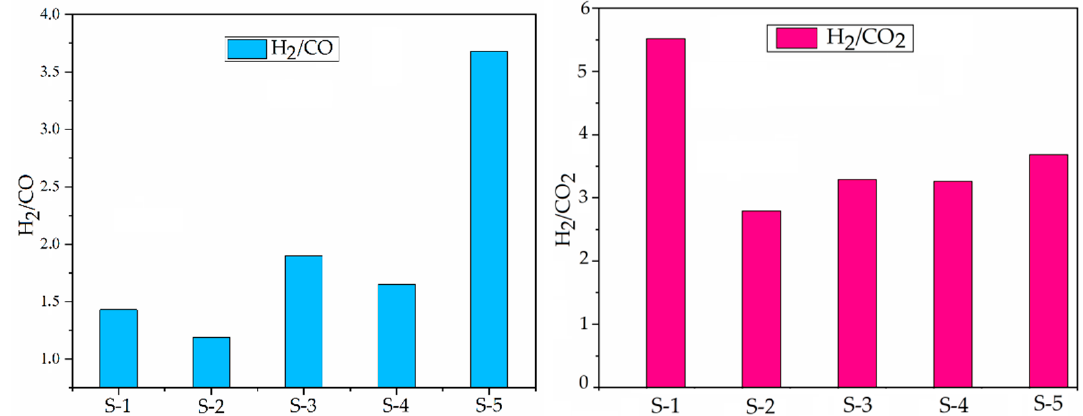
Figure 2. Hydrogen to monoxide carbon ratio after H 2 /CO and H 2 /CO 2 .